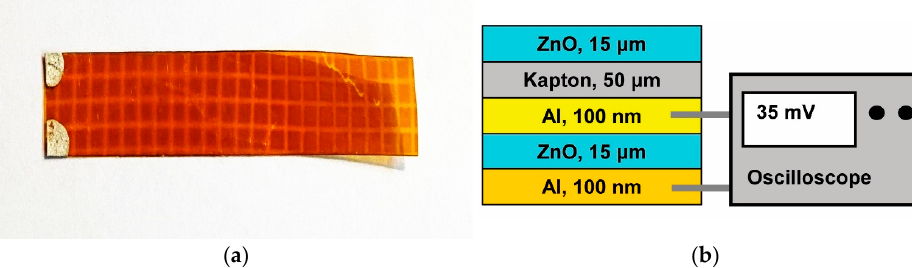
Figure 10. The vibro-piezo-transducer (6 × 35 mm 2 ) based on Al/ZnO/Al/Kapton/ZnO structure with two metallic electrodes (left). ( a )—photo, ( b )—schematic view.